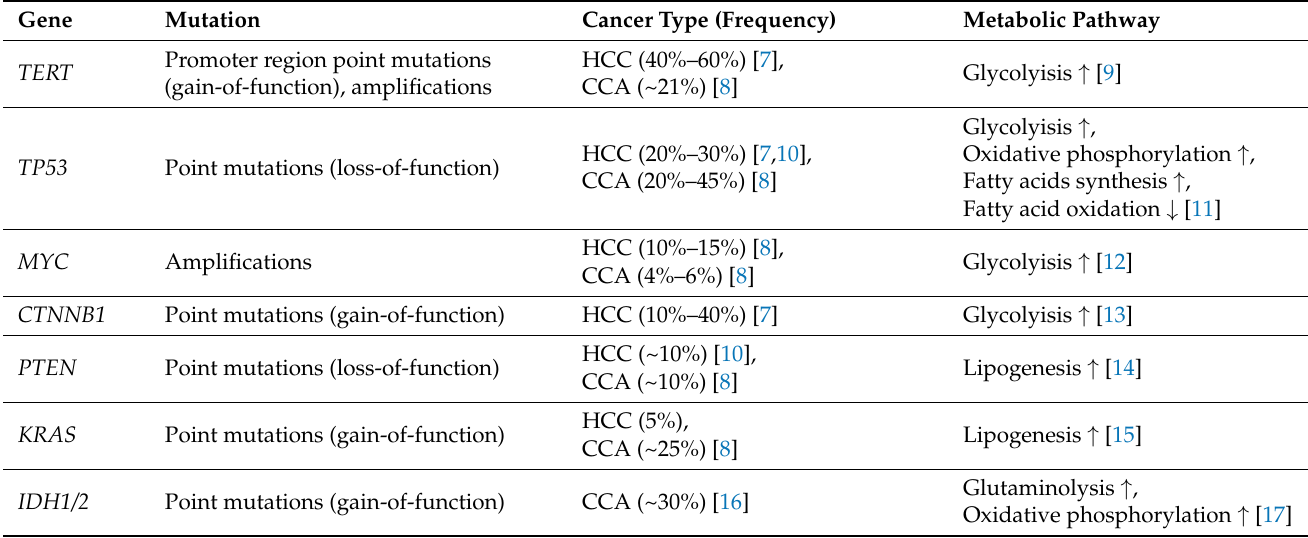
Table 1. Metabolism-related gene mutation in liver